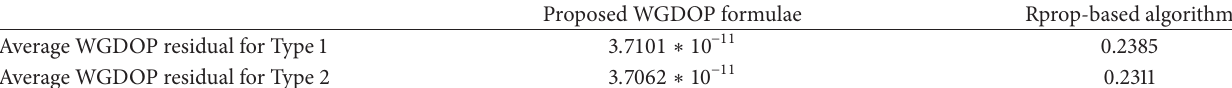
Table 3: Comparison of average WGDOP residual for the proposed formulae and Rprop-based algorithm.